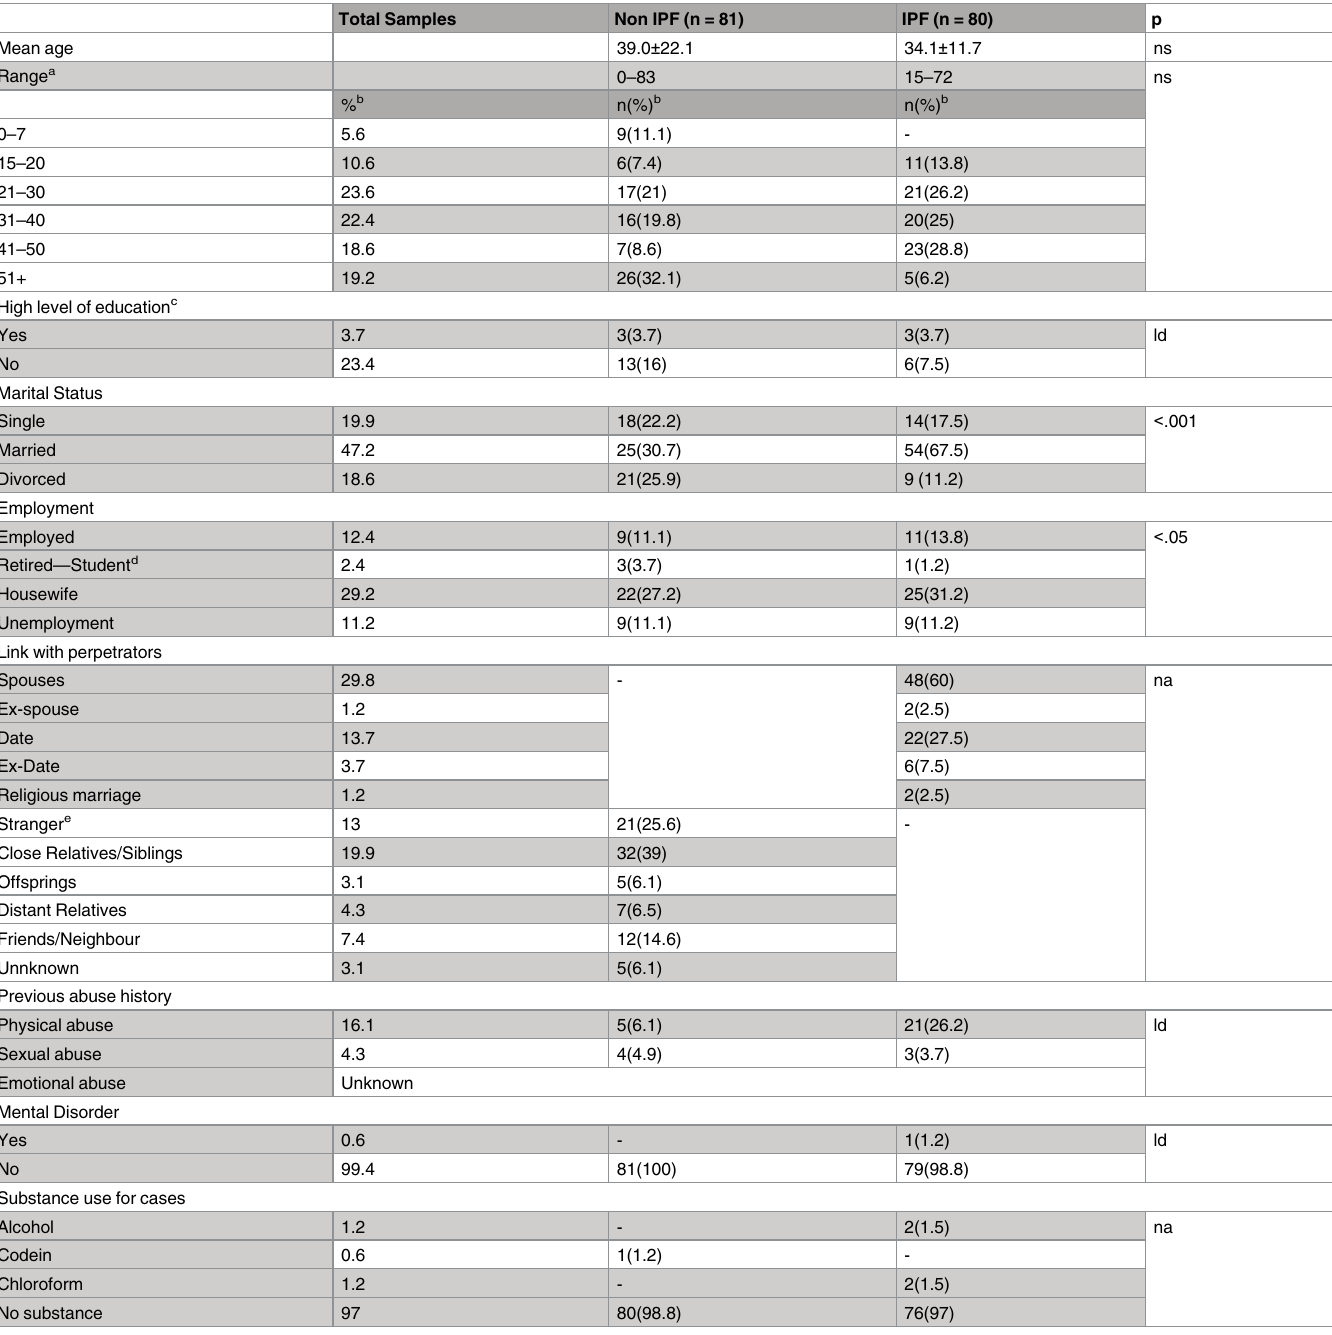
Table 2. Socio-demographic characteristics of victims and general risk factors for homicide, by group. ld: not analyseddue to limited data; na: not analysed;ns: no